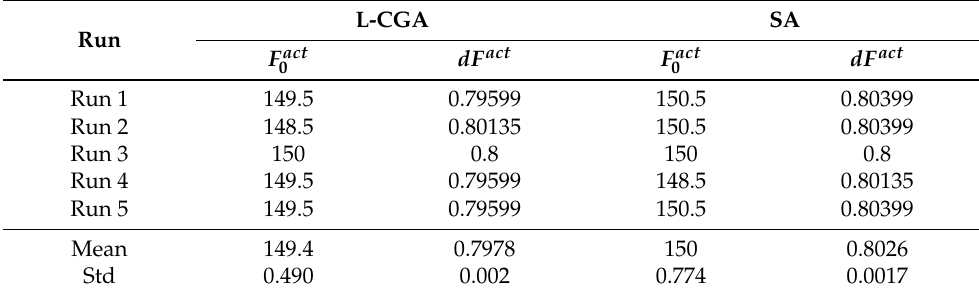
Table 7. Comparison of resonator characteristics achieved by L-CGA and SA, 6 mode case.